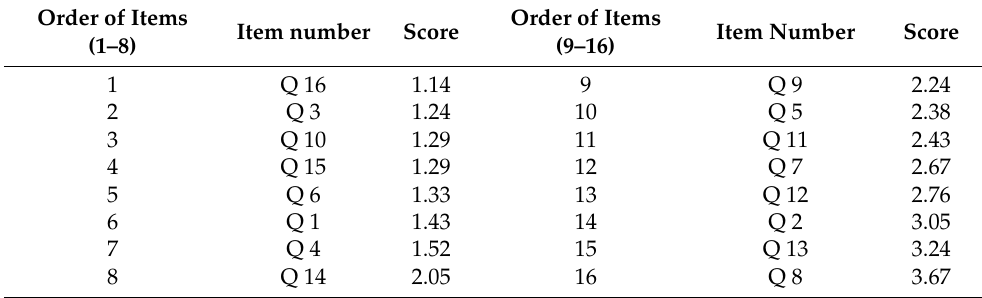
Table 8. Ranking of items on CASQ, based on the answers.